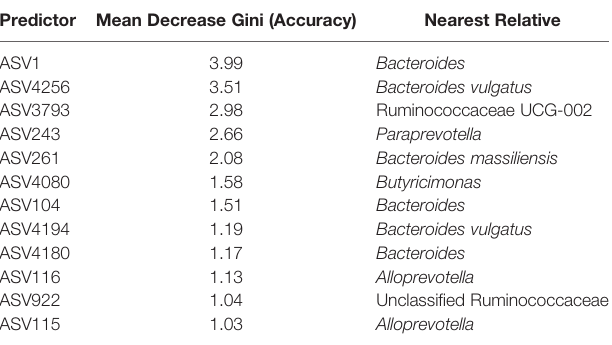
TABLE 2 | ASVs identi fi ed with greater than 1% effect in mean model accuracy